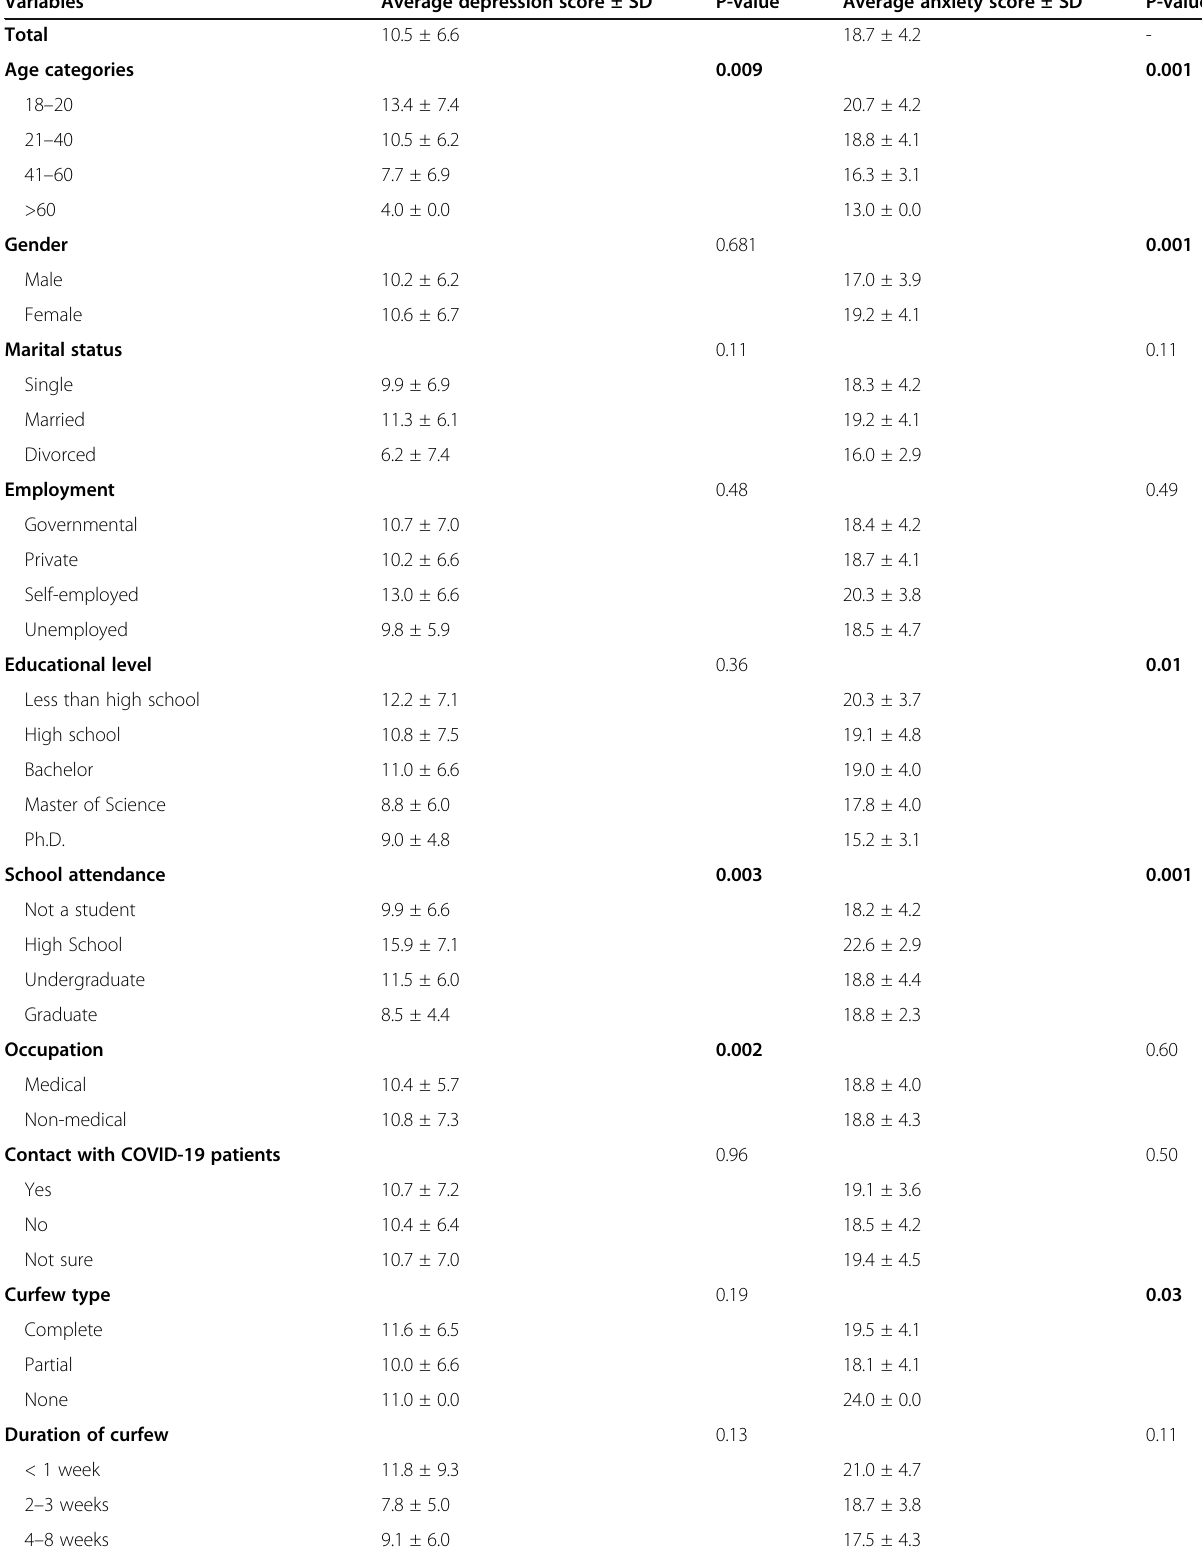
Table 2 Target symptoms stratified according to participant ’ s baseline